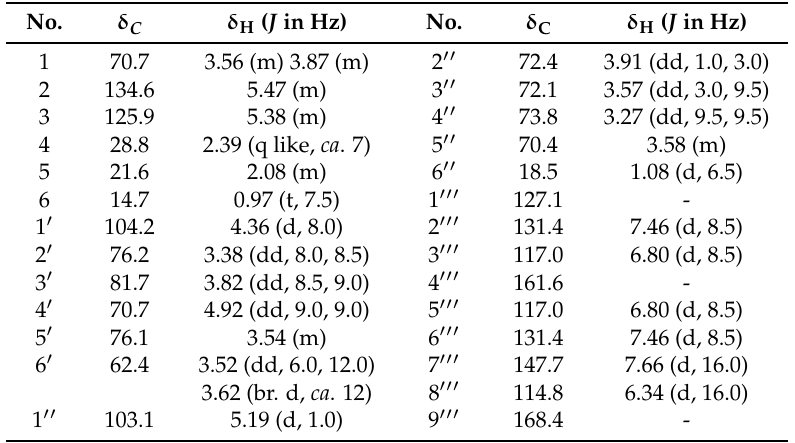
Table 3. The 1 H- and 13 C-NMR data of 3 in CD 3 OD.